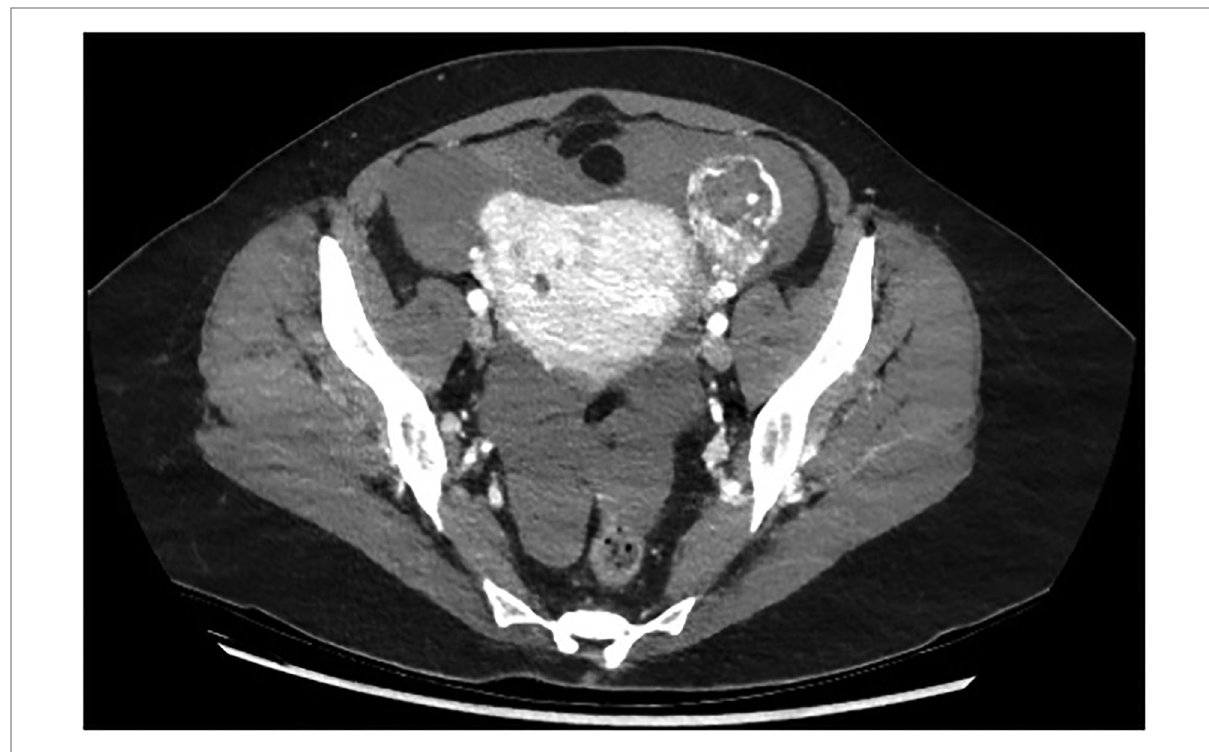
FIGURE 2 Ct scan: after intravenous injection of iobitridol (iodinated contrast agent), the CT scan showed the left adnexal mass with areas of low attenuation internally, outlined by highly enhanced contours.